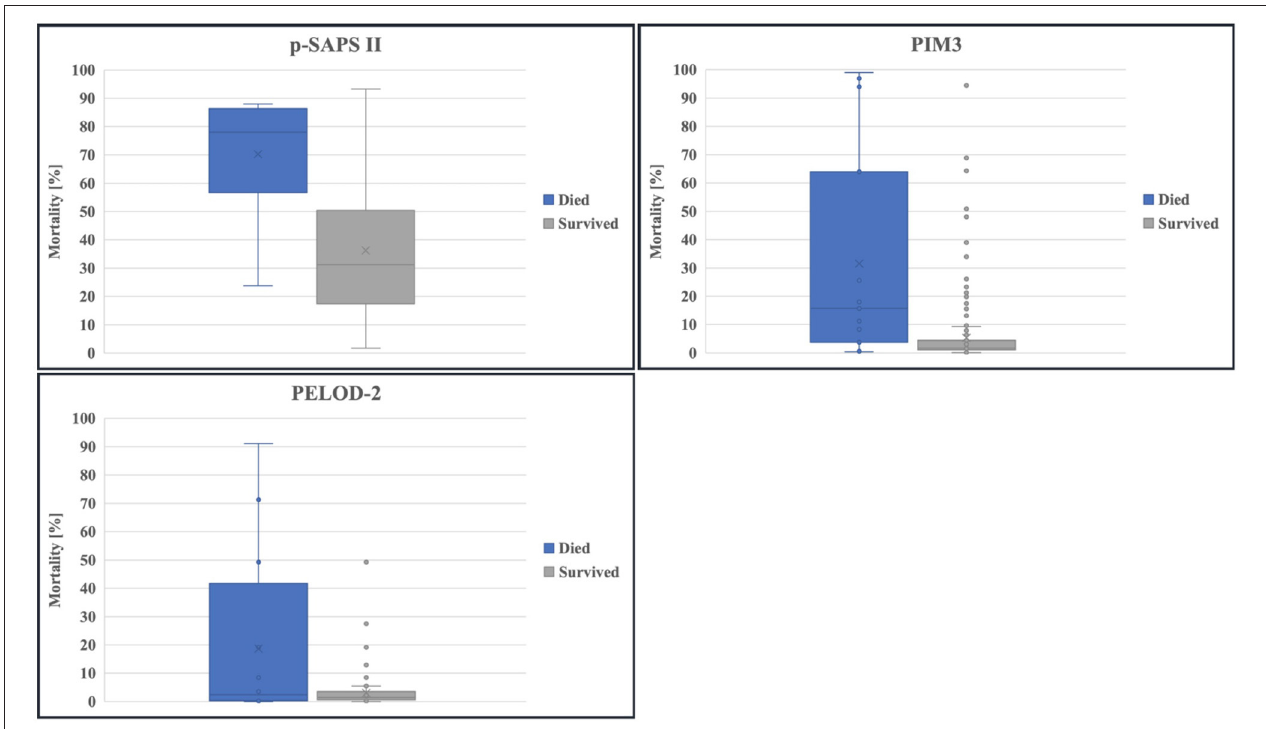
FIGURE 3 | Boxplot of calculated mortality risks: survivors compared to